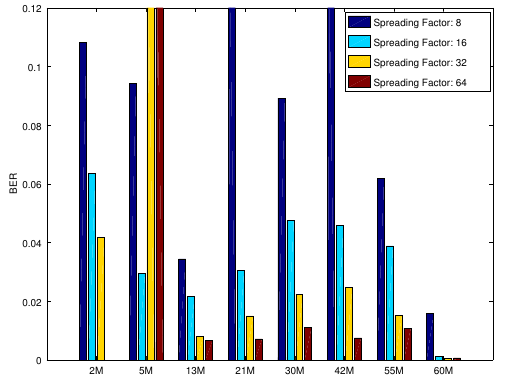
Figure 11: Time domain plot of received sig- nal (blue) and reference signal (green) at 21MHz, spreading factor 8 with d = 22 . 5 cm